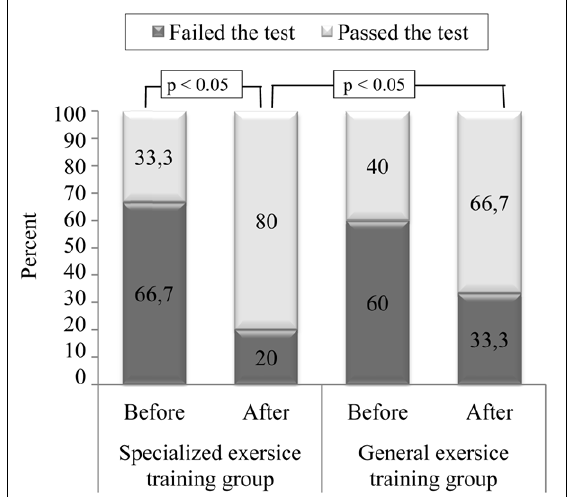
Figure 6. Sitting knee